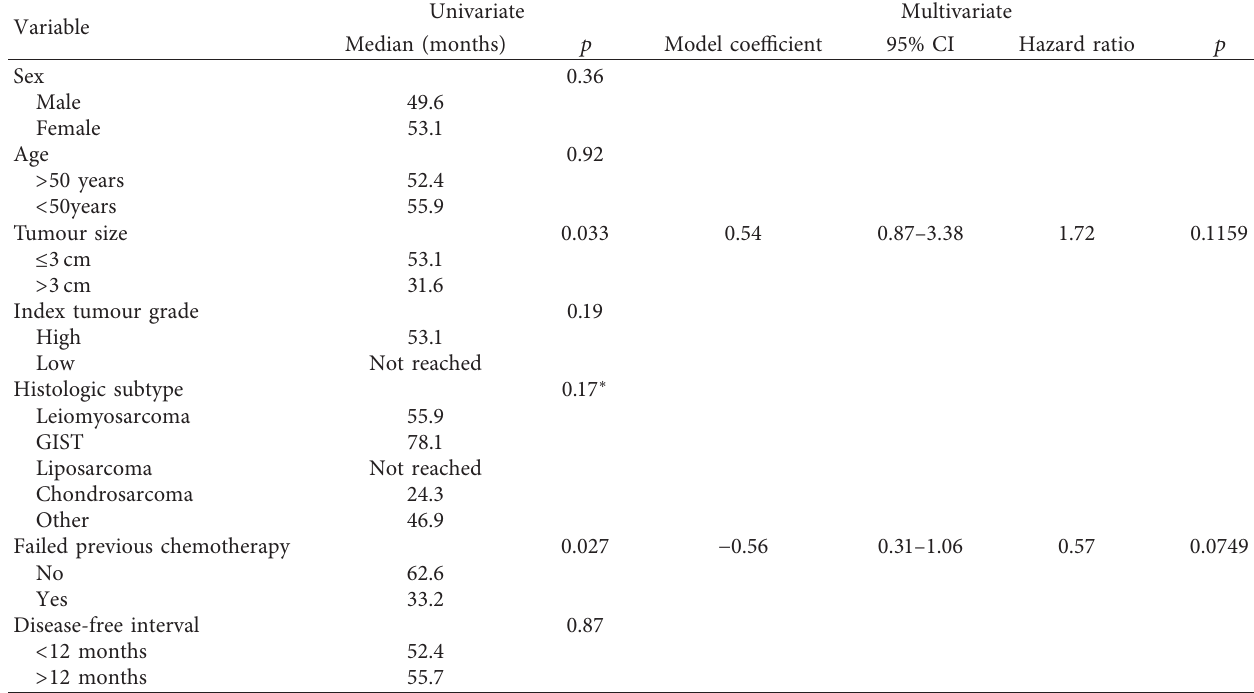
Table 2: Overall survival in sarcoma patients undergoing ablation.